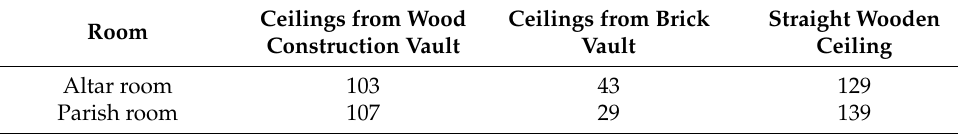
Table 4. Number of churches with different types of ceilings over the